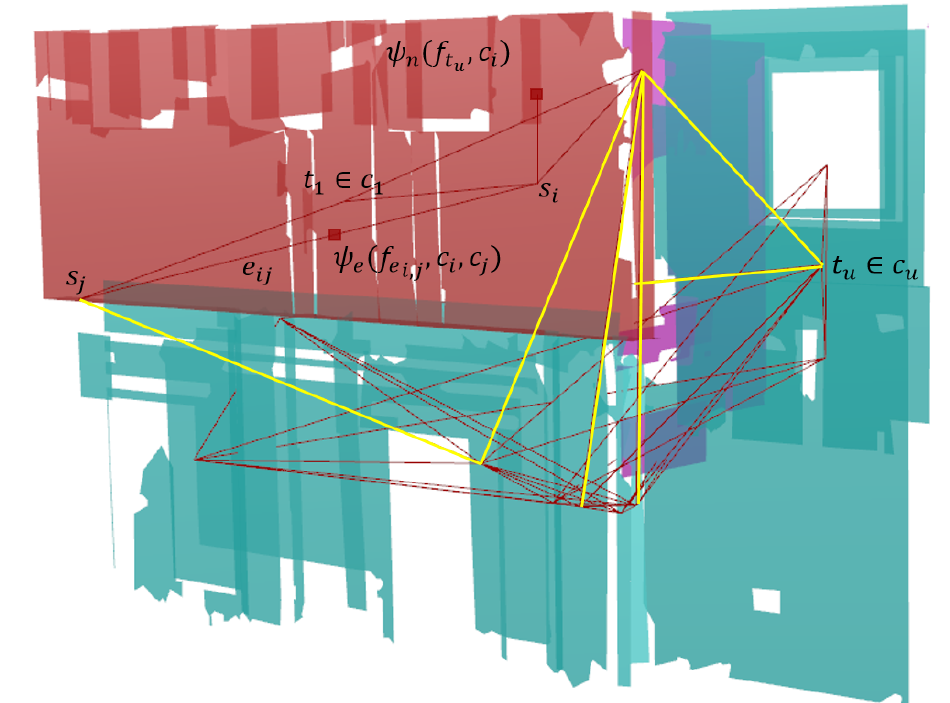
Figure 3. Illustration of the connected components with the remaining edges in a highly associative configuration. The three clusters are depicted in red, cyan, and purple. The edges are shown in red and the edges between clusters are shown in